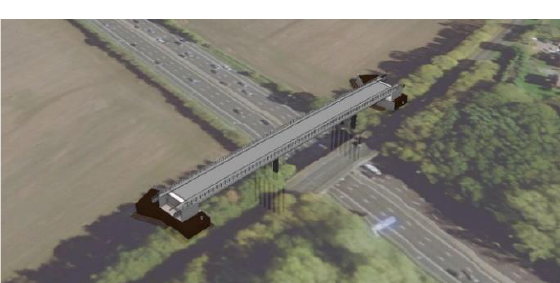
Figure 5 . GIS Output in 2D.